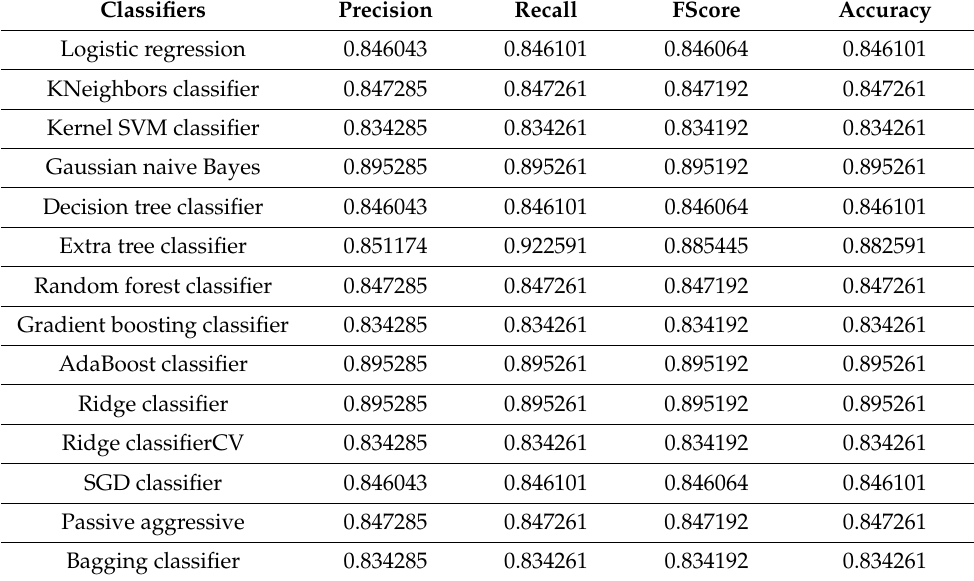
Table 10. AdaBoost regressor metrics after feature scaling.